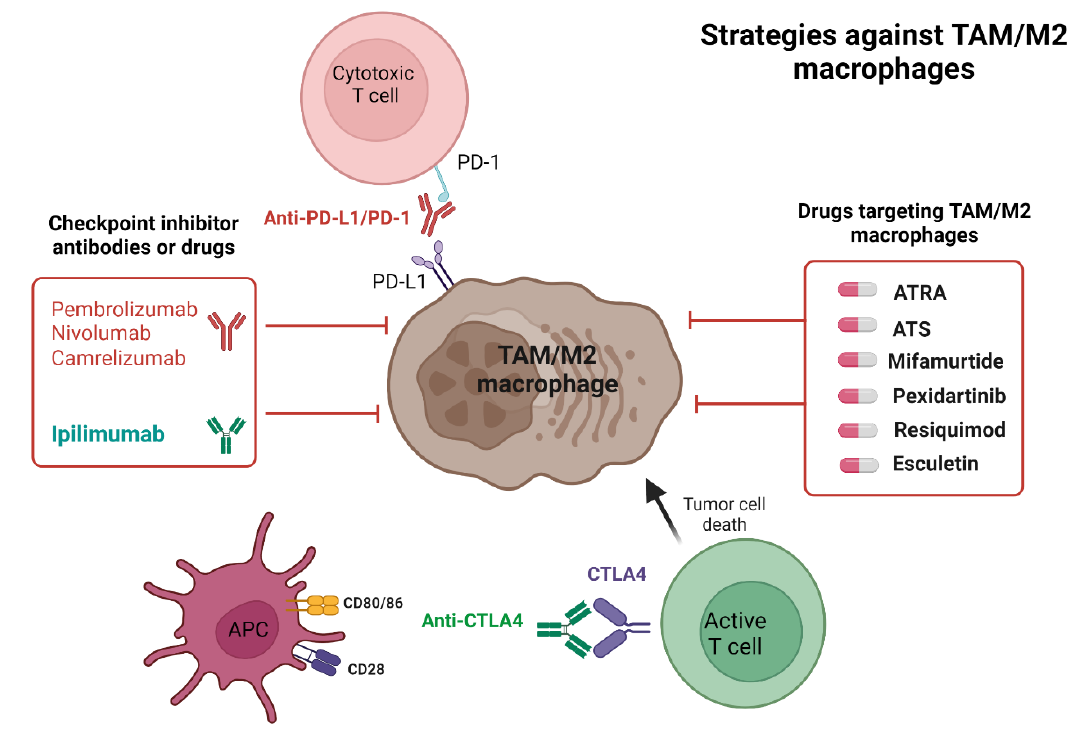
Figure 2. TAM/M2 macrophage targeting strategies. In the tumor microenvironment, T cells express PD-1, which can interact with its ligand PD-L1 on cancer cells as well as M2 macrophages, resulting in the inactivation of T cell function. Anti-PD-L1/PD-1 antibodies block this interaction, and T cells are subsequently activated and have anti-cancer activity. The repolarization of M2 macrophages to the M1 phenotype also reduces PD-L1 expression in the tumor microenvironment. Various agents that can re-polarize TAMs/M2 macrophages are being developed, and those under development as strategies to target the macrophage population are shown in the image. Adapted from “Immune Therapy in Multiple Myeloma”, by BioRender.com (2023). Retrieved from https://app.biorender.com/biorender-templates (accessed on 30 January 2023).